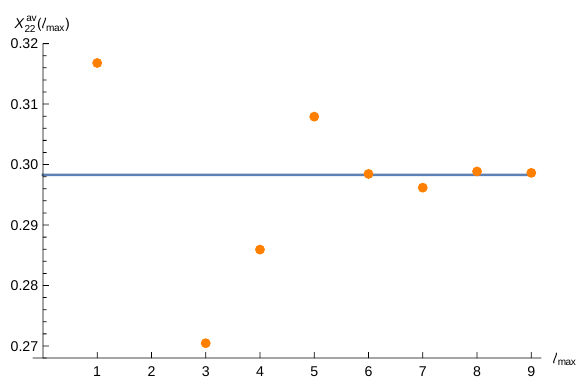
Figure 1 . Orange dots show X av horizontal line at 0 : 29831 represents X KZ